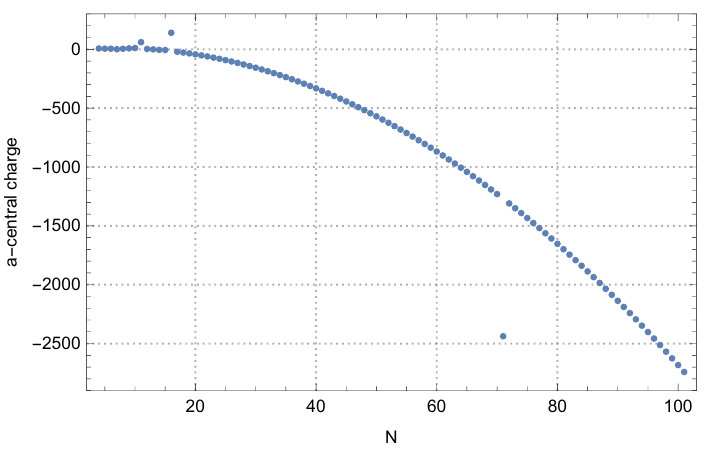
Figure 4 . The numerical results of the a -maximisation: the central charge is displayed against varying rank N of the gauge nodes. Note that the numerical results for N = 12 ; 16 ; 71 seem to be (cid:13)awed.